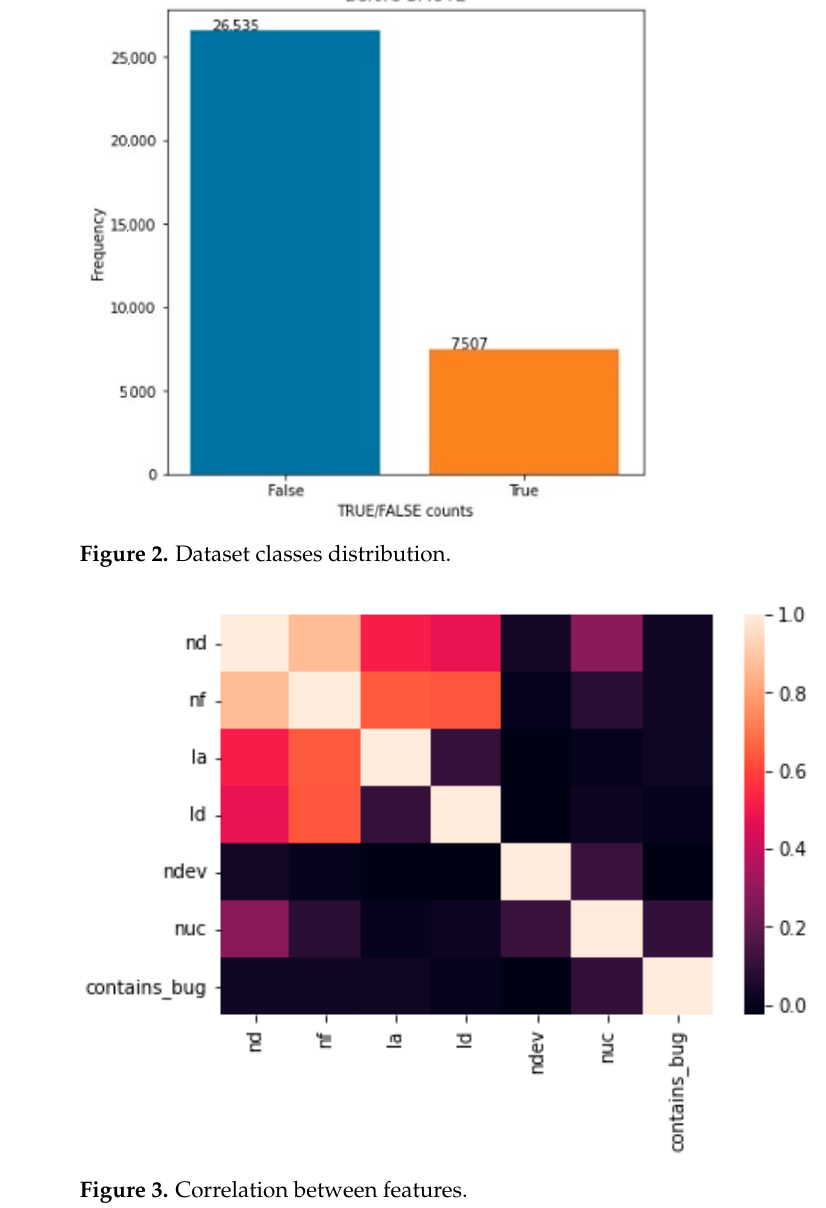
Figure 2. Dataset classes distribution.